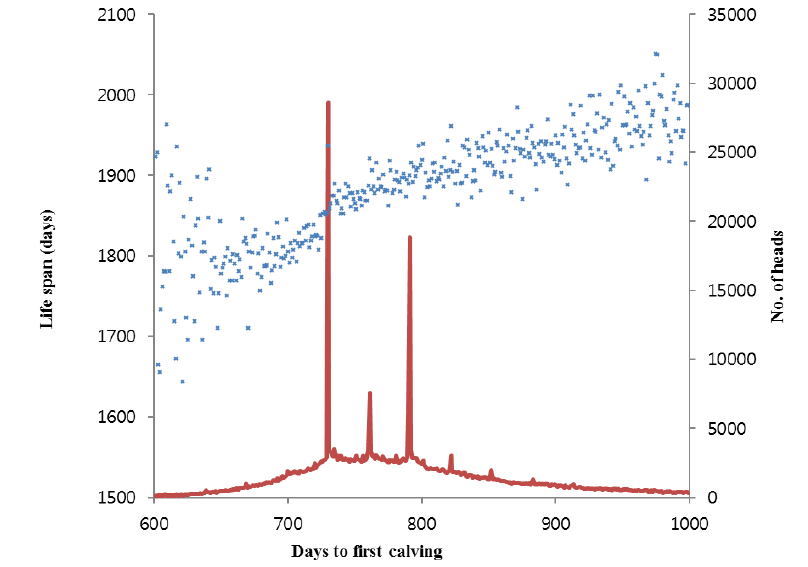
Figure 2. Frequency of age (days) at first calving and life span (days) according to days to first